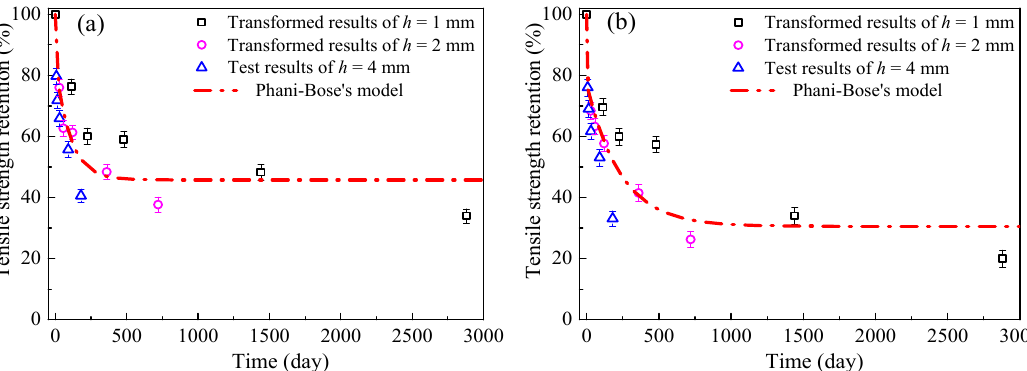
Figure 17. Accelerated ageing results of tensile strength retention based on specimen thickness: ( a ) deionized water and ( b ) alkaline solution.